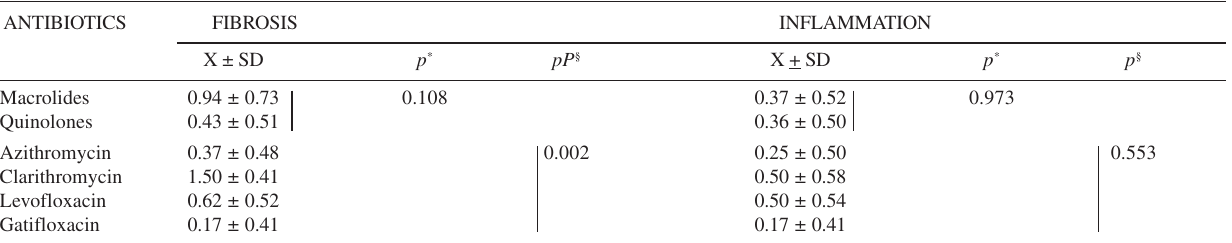
Table 3 - Scores for pleural fibrosis and inflammation observed microscopically in the injected hemithorax